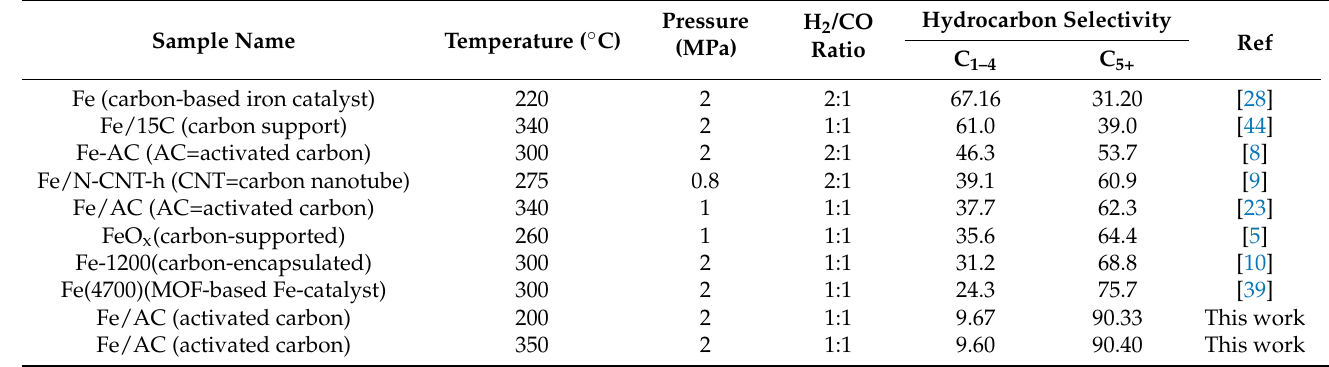
Table 4. Hydrocarbon selectivity of different Fe-carbon-supported